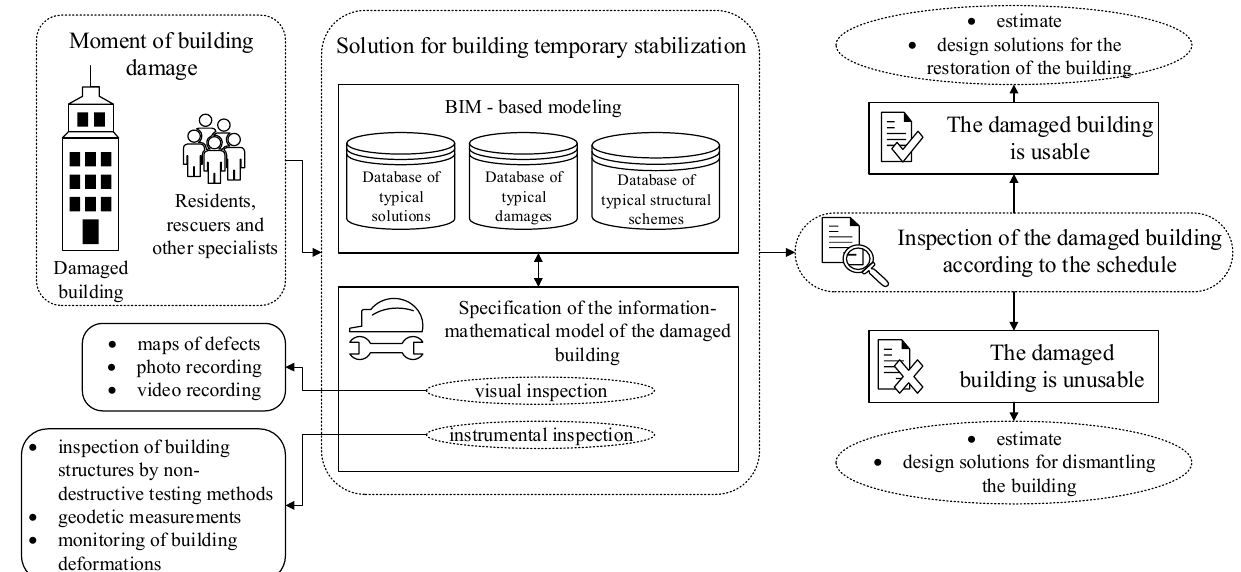
Figure 12. The proposed conceptual scheme for assessing the technical condition of a damaged large-panel building using a database of typical solutions and a preliminary remote assessment at the stage of emergency and rescue operations.